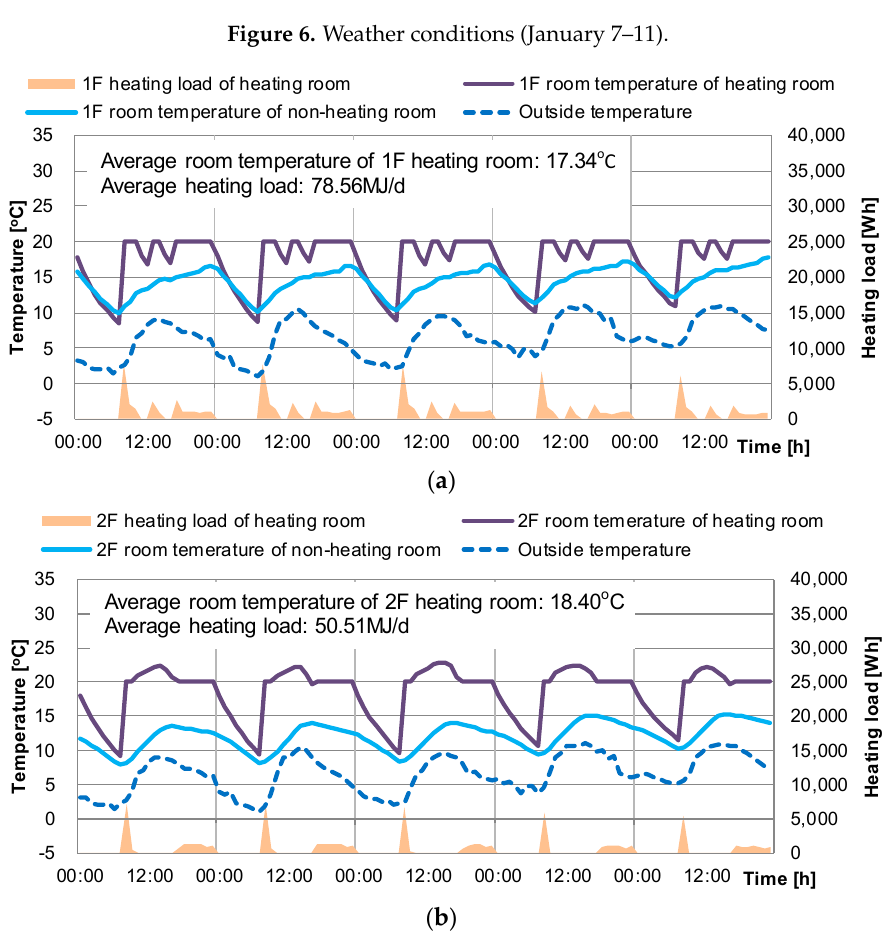
Figure 7. Room temperature results of a typical house. ( a ) First floor; ( b ) Second